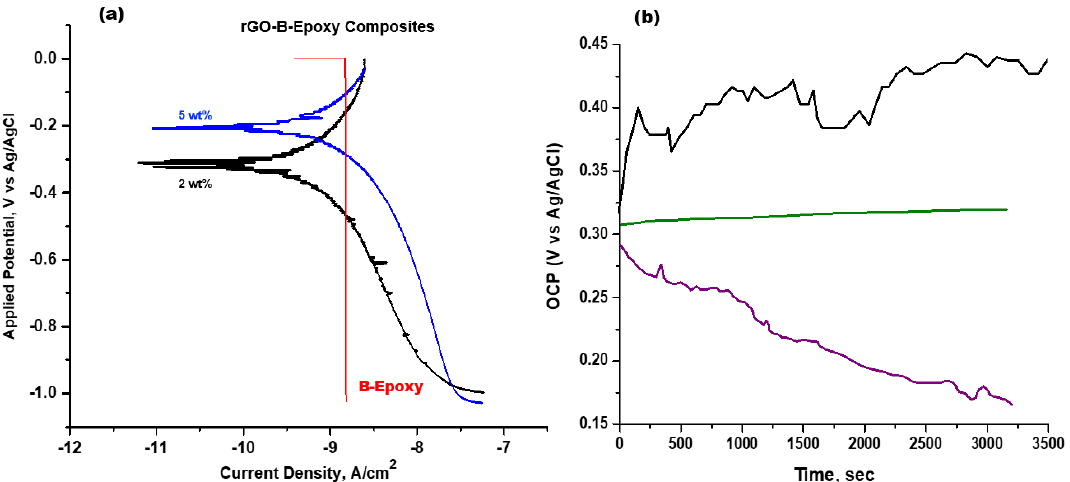
Figure 7. ( a ) TAFEL plot and ( b ) OCP for rGO − B − epoxy and B − epoxy. (black for B − epoxy; green for 2 wt% rGO − B − epoxy, and purple for 5 wt% rGO − B − epoxy)